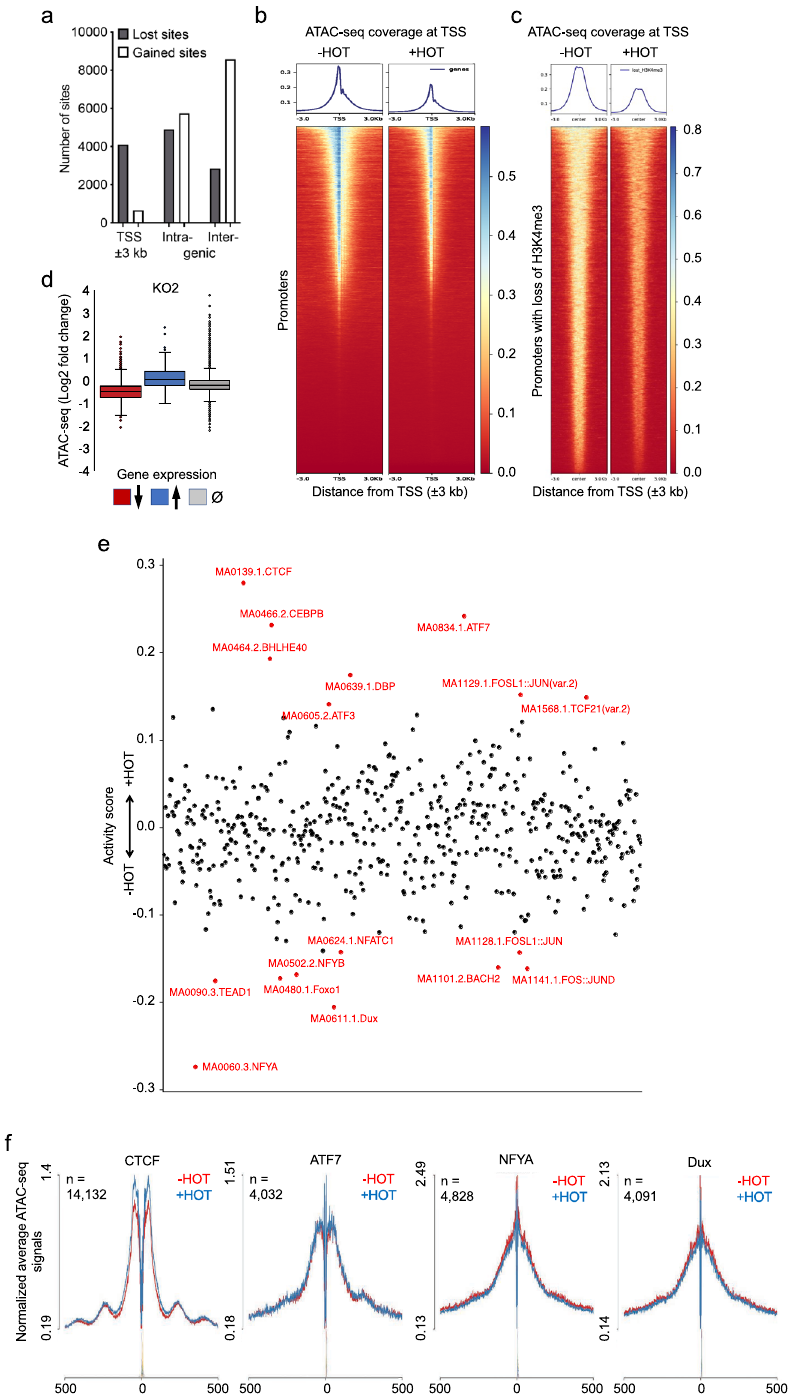
Figure 3. Ash2l loss induces chromatin compaction. ( a ) Lost and gained ATAC sites as defined after differential analysis using Deseq2 (q < 0.05; log2FC > 0.4) were analyzed at promoters (± 3000 bp of TSS), and in intra- and intergenic regions. ( b ) Heatmaps generated using DeepTools showing normalized ATAC-seq signals (normalized using counts per million (CPM)) in the presence and absence of Ash2l (± HOT) at all annotated transcripts in mm9 (± 3000 bp of TSS). ( c ) Heatmaps comparing chromatin accessibility by ATAC of promoters that lost H3K4me3 in the presence or absence of Ash2l (± HOT). ( d ) The promoters of genes that are up- or downregulated or did not change in expression in response to ± HOT treatment were evaluated regarding their accessibility in the ATAC-seq approach. ( e ) Transcription factors (TFs) footprinting and their differential analysis in the ATAC-seq data set were performed using RGT-HINT. In red are TFs with more than 1000 binding sites with altered accessibility (q < 0.05). A summary of these sites is given in Supplementary Table S4. ( f ) Line plots for two TFs showing lost activity (increased binding of CTCF and ATF7) and two TFs with gained activity (decreased binding of NFYA and Dux) upon Ash2l loss in KO2 as defined in panel ( e